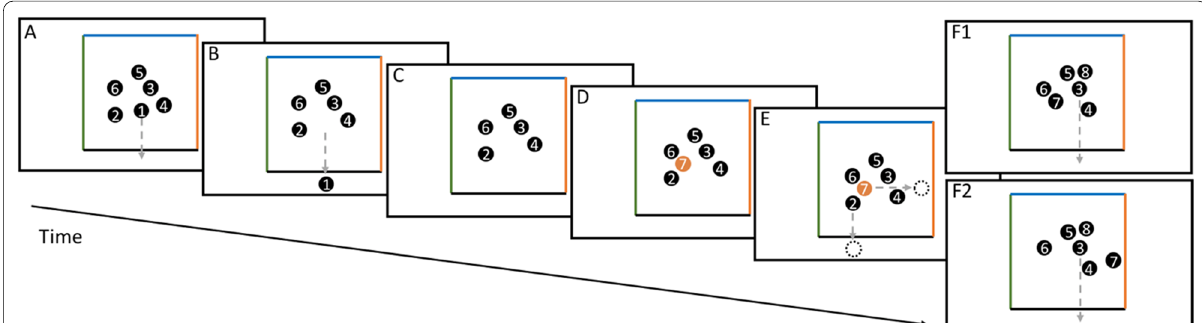
Fig. 1 Illustration of the intention offloading task. A: A set of six circles appears onscreen. B: The participants drag the circles in the order indicated by the numbers. C: Dragged circles disappear from the display. D: For each removed circle, a new circle appears (until a total of 25 circles had been presented). New circles can be associated with an intention (indicated by a 2 s color cue). These circles need to be dragged across the correspondingly colored border of the frame when it is their turn. E: For circles which are associated with an intention, the participants can decide whether to rely on an internal memory strategy (see F1), or whether they externalize the intention by locating the circle near the corresponding border thus generating an external reminder (see F2). Cognitive offloading is indicated by a larger number of